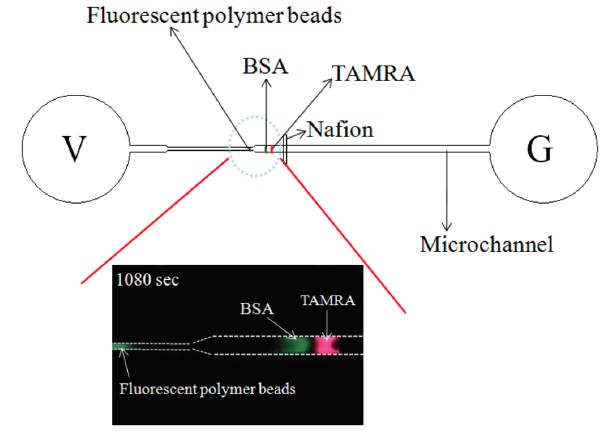
Figure 9. Schematic illustrations of the superimposed image showing the BSA/beads and TAMRA, respectively. It clearly shows the mixed species are both concentrated and separated.